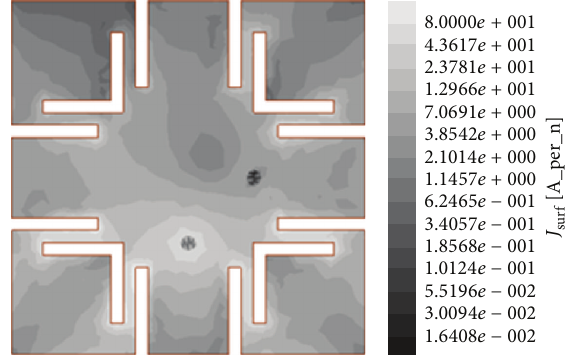
Figure 9: Simulated patch surface current magnitude distribution of phase 0 at